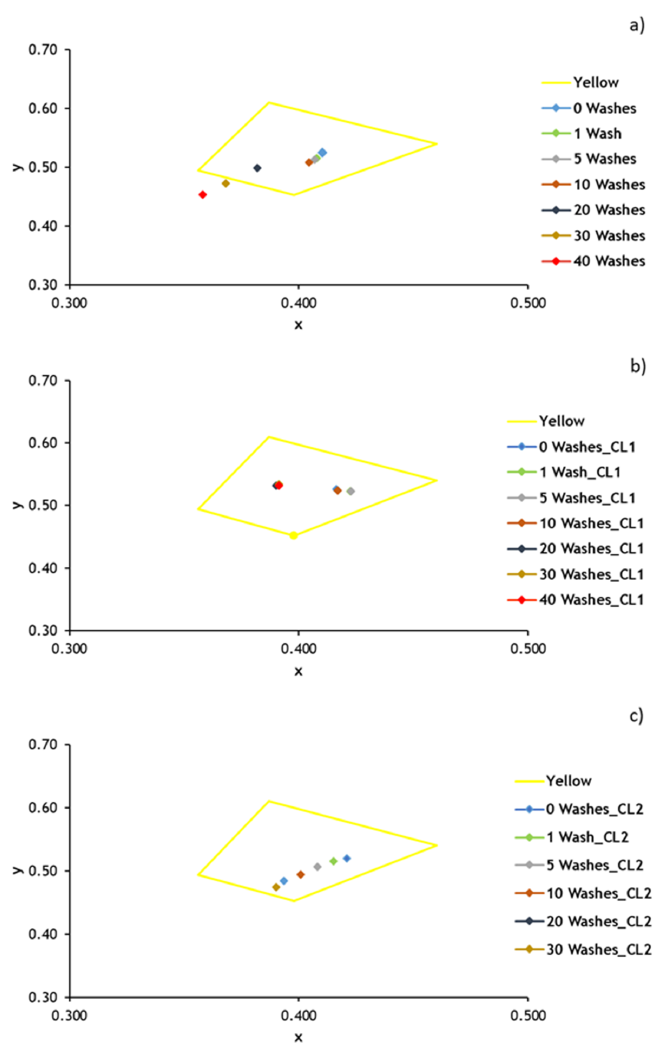
Figure 3. Chromaticity coordinates obtained for samples with 15% of YE 517 pigment: ( a ) sample without cross-linker; ( b ) sample with cross-linker 1; ( c ) sample with cross-linker 2.